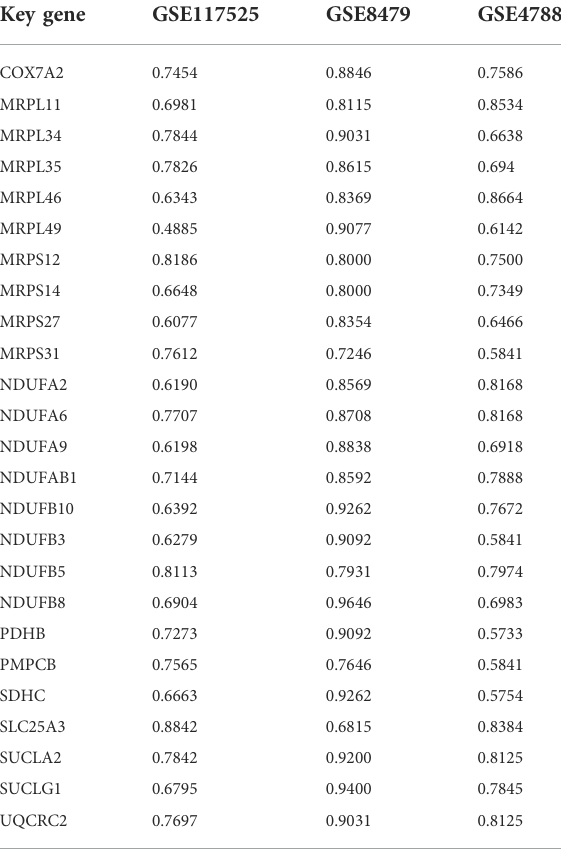
TABLE 1 The AUC value of key genes in the three datasets. Key